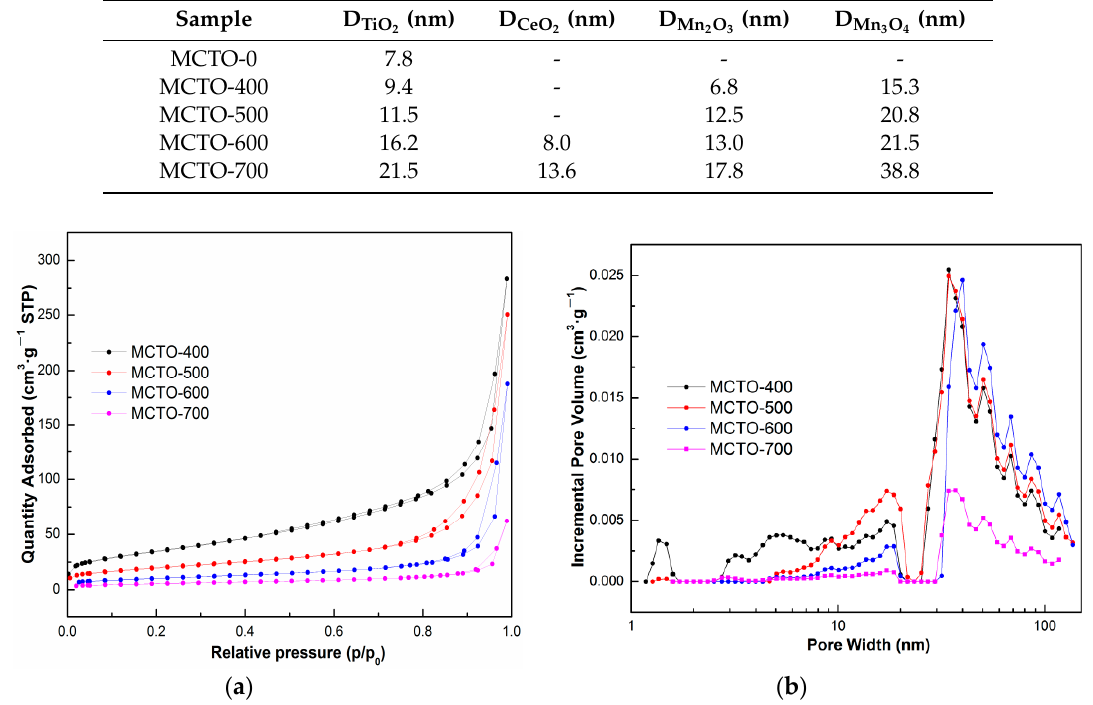
Figure 3. N 2 adsorption/desorption isotherms ( a ) and the corresponding pore size distributions ( b ) of MCTO-400, MCTO-500, MCTO-600, and MCTO-700.